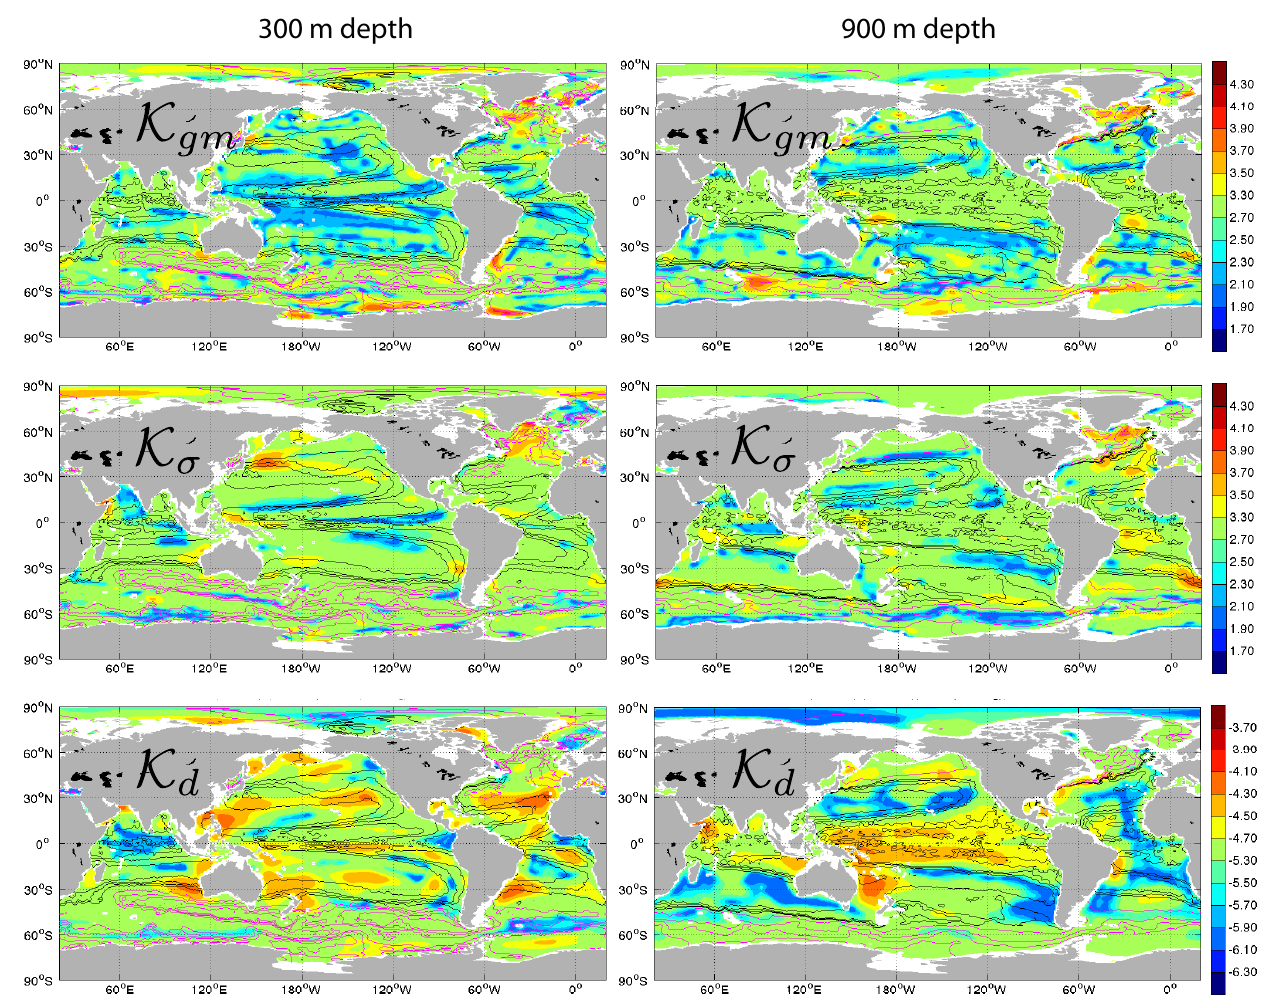
Figure 9. Estimated bolus velocity coefficient (top), isopycnal diffusivity (middle) and diapycnal diffusivity (bottom) at 300m depth (left) and 900m depth (right) in square meters per second (log 10 color scale). The respective first guess values are 10 3 , 10 3 and 10 − 5 m 2 s − 1 . Each overlaid contour corresponds to a percentile of the observed stratification map ∂ρ Black contours (resp. magenta contours) denote the 60th, 70th, 80th, and 90th (resp. 10th, 20th, 30th, and 40th) percentiles of ∂ρ